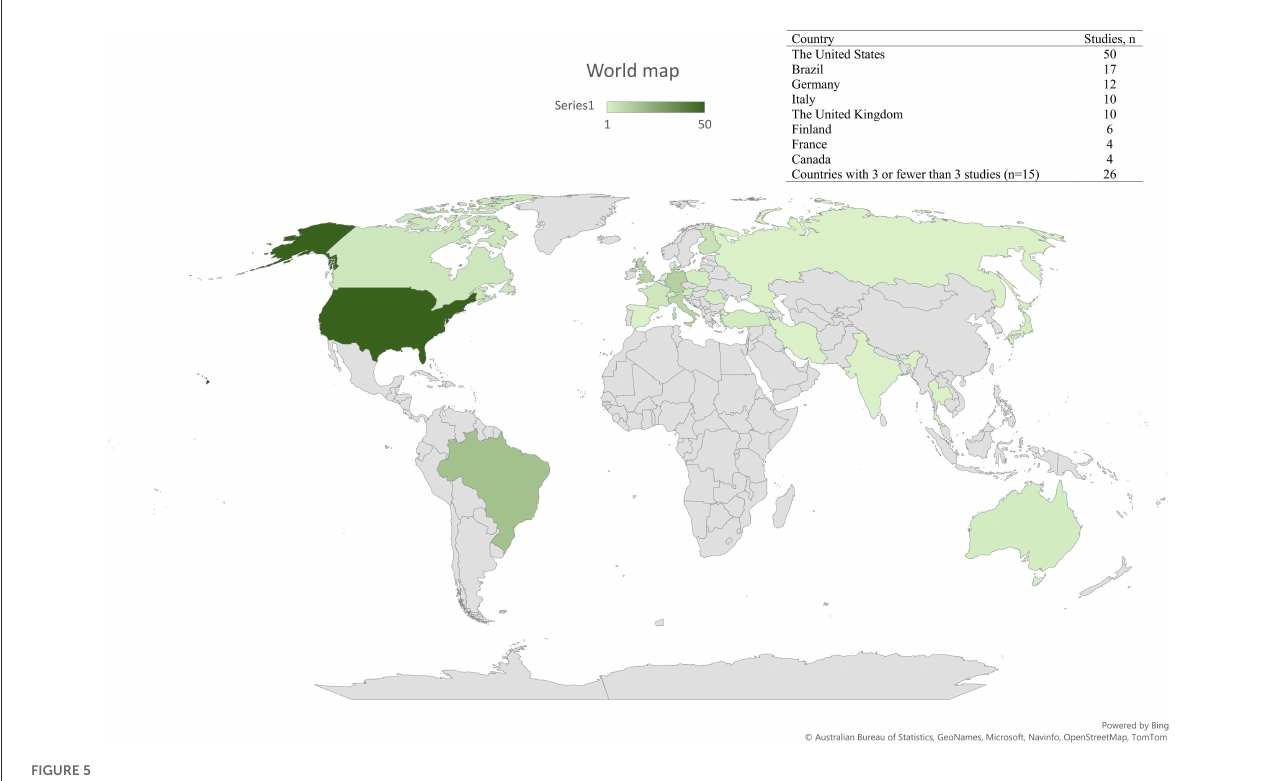
FIGURE5 Geographical distribution of where the 139 included studies were conducted.